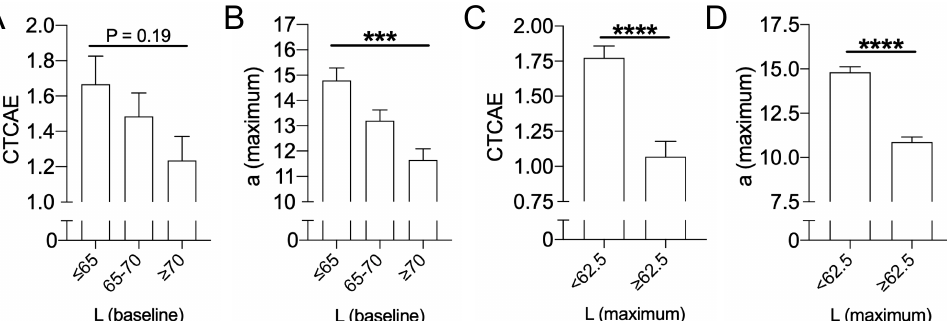
Figure 3. Initial dark skin is a positive risk factor for severe RID. ( A ) Maximum dermatitis severity assessed by physicians according to CTCAE v4.03 in relation to initial (pre-treatment) lightness of the skin. ( B ) Maximum dermatitis severity measured by spectrophotometry as maximum a* values in relation to initial (pre-treatment) lightness of the skin. ( C ) Maximum dermatitis severity assessed by physicians according to CTCAE v4.03 for either dark (L* max < 62.5) or light (L* max ≥ 62.5) skin during RID. ( D ) Maximum dermatitis severity measured by spectrophotometry as maximum a* values for either dark (L* max < 62.5) or light (L* max ≥ 62.5) skin during RID. One-way-ANOVA has been conducted for significance detection in panels ( A + B ), unpaired t -tests for panels ( C + D ) with *** for p < 0.001, and **** for p < 0.0001.